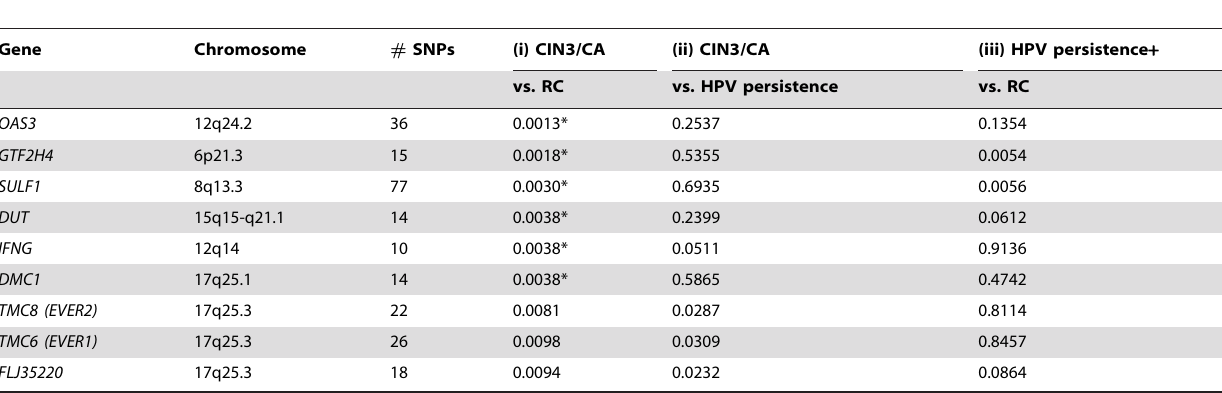
Table 2. Significance levels (p values) for (i) cervical precancer/cancer, (ii) progression to cervical precancer/cancer, and (iii) HPV persistence, among gene regions with p , 0.01 for an association with cervical precancer/cancer.